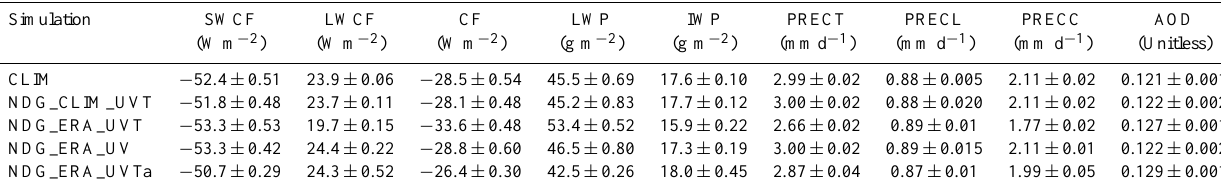
Table A1. Global mean metrics in free-running and nudged present-day simulations. Meanings of the acronyms are: SWCF: shortwave cloud forcing; LWCF: long-wave cloud forcing; CF: total cloud forcing; LWP: liquid water path; IWP: ice water path; PRECT: total precipitation rate; PRECL: large-scale precipitation rate; PRECC: convective precipitation rate; AOD: aerosol optical depth at 550nm wavelength. All results are given as 5yr (2006–2010) average ± one standard deviation of the annual mean.